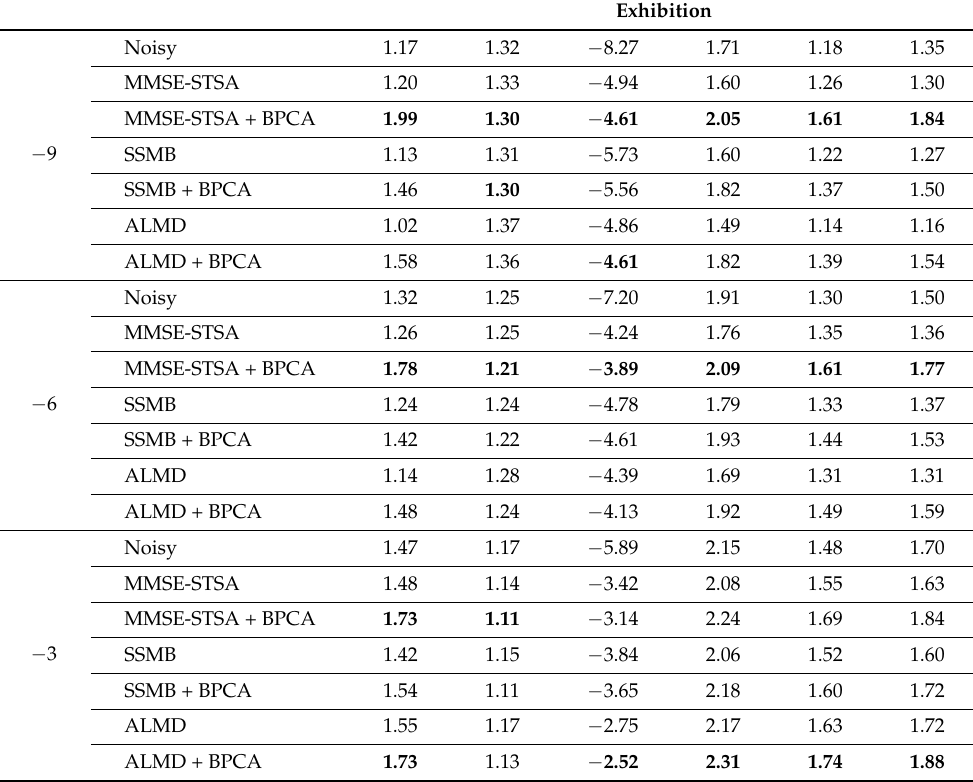
Table 4. All performance metric scores for noise type ‘Exhibition’ over multiple SNR levels. Best results are highlighted in bold